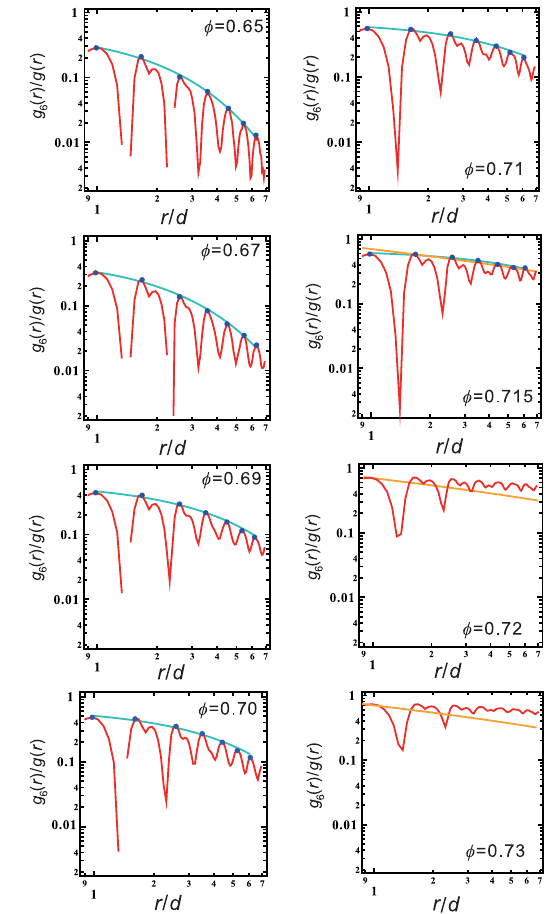
FIG. 3. Examples of the analysis of the spatial decay of g 6 ð r Þ =g ð r Þ for a steel ball system for Γ ¼ 3 . 3 . The blue points are used for the fittings. The blue curves are exponential fittings, whereas the orange lines have a slope of − 1 = 4 , which is expected at ϕ . From the above, we can judge that the liquid-to-hexatic h transition takes place between ϕ ¼ 0 . 715 and 0.72. The accuracy of this determination is limited by the discreteness of the area fractions we